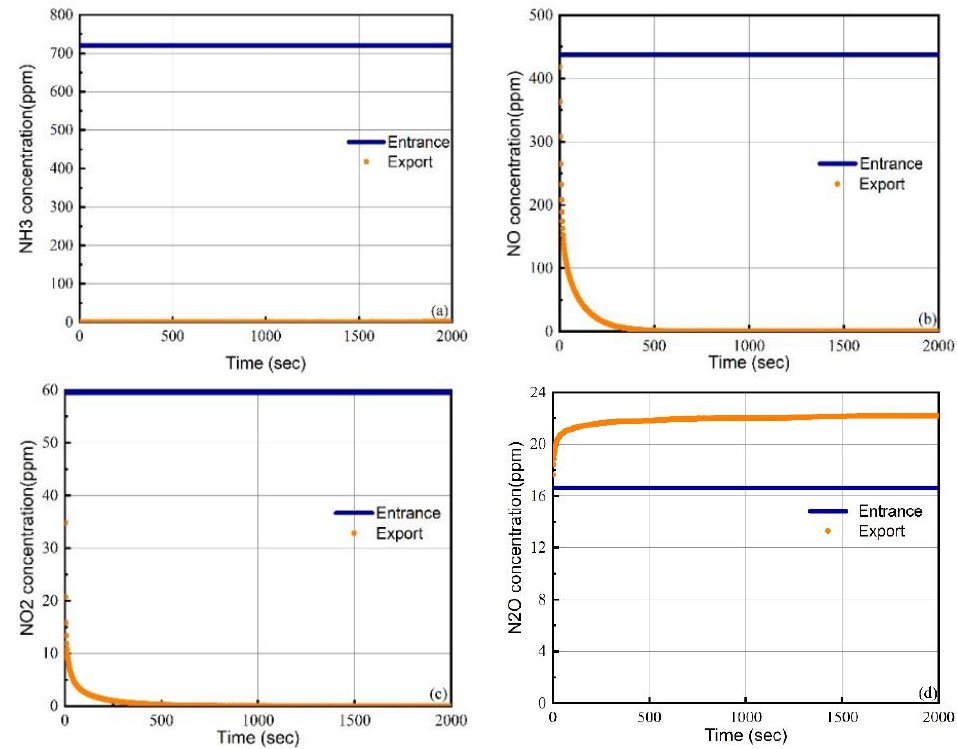
Figure 10. Comparison of NOx and unburned ammonia concentrations at SCR inlet and outlet in Case 3. ( a ) NH 3 concentration on entrance and export. ( b ) NO concentration on entrance and export. ( c ) NO 2 concentration on entrance and export. ( d ) N 2 O concentration on entrance and export.